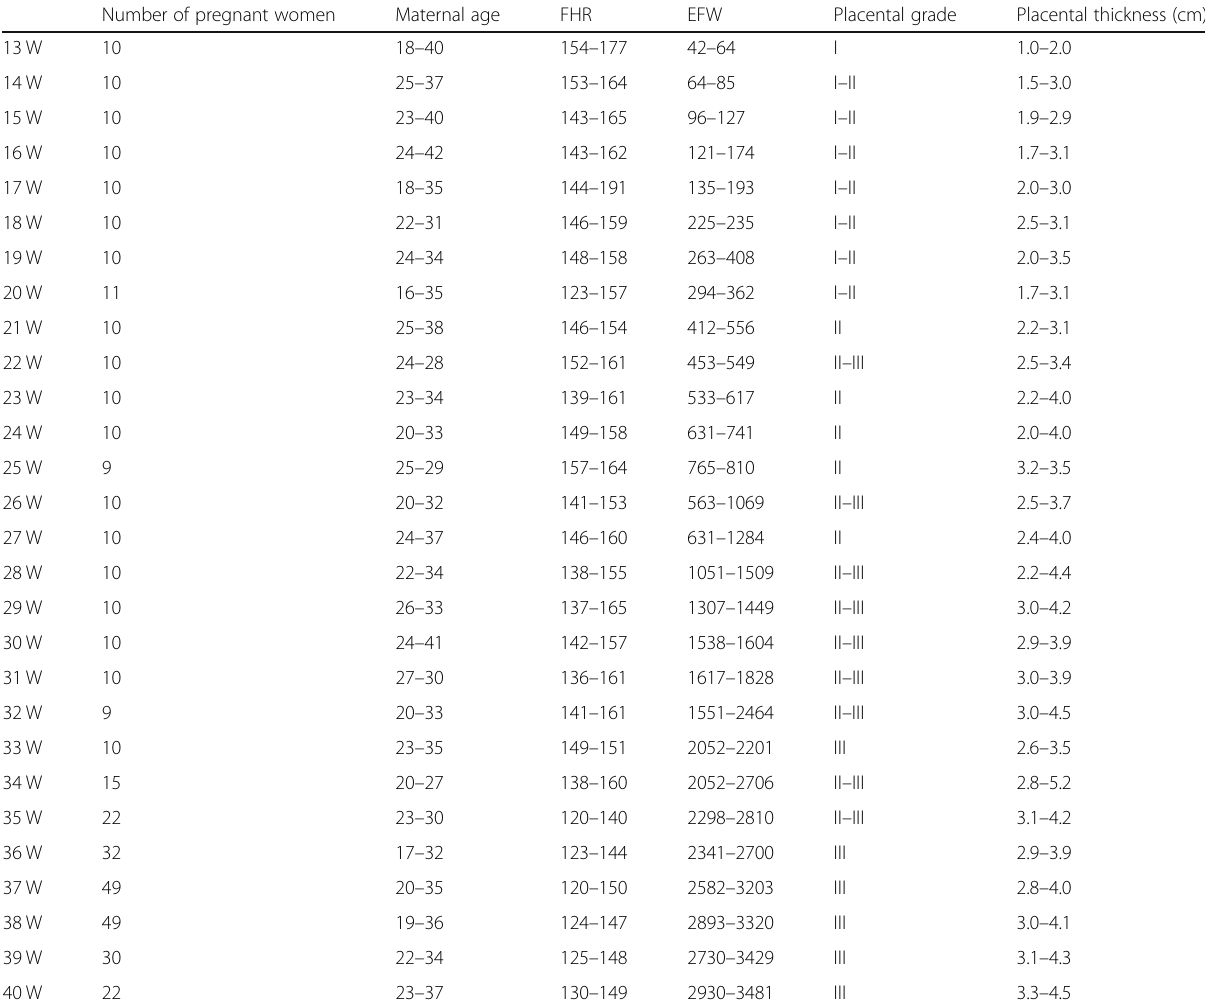
Number of pregnant